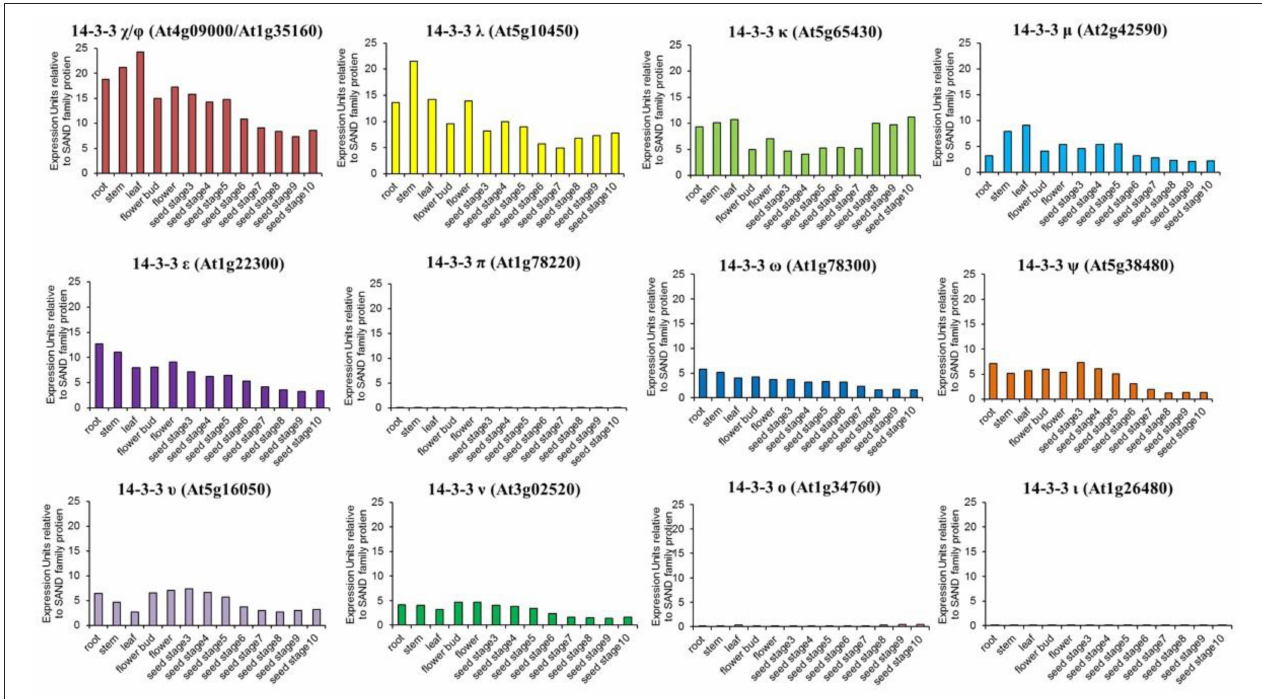
FIGURE 3 | Organ-specific Arabidopsis 14-3-3 expression profiles. Gene expression data were obtained from EFP Browser. The y-axis represents raw expression units and is relative to SAND family (At2g28390) expression levels. The oligo-probe used in the microarrays cannot distinguish between 14-3-3 χ (At4g09000) and Φ (At1g35160), thus the gene expression data were plotted together. The following organs were used in the analysis: root, stem, leaf, flower bud, flower, seed stage3, seed stage4, seed stage5, seed stage6, seed stage8, seed stage9, and seed